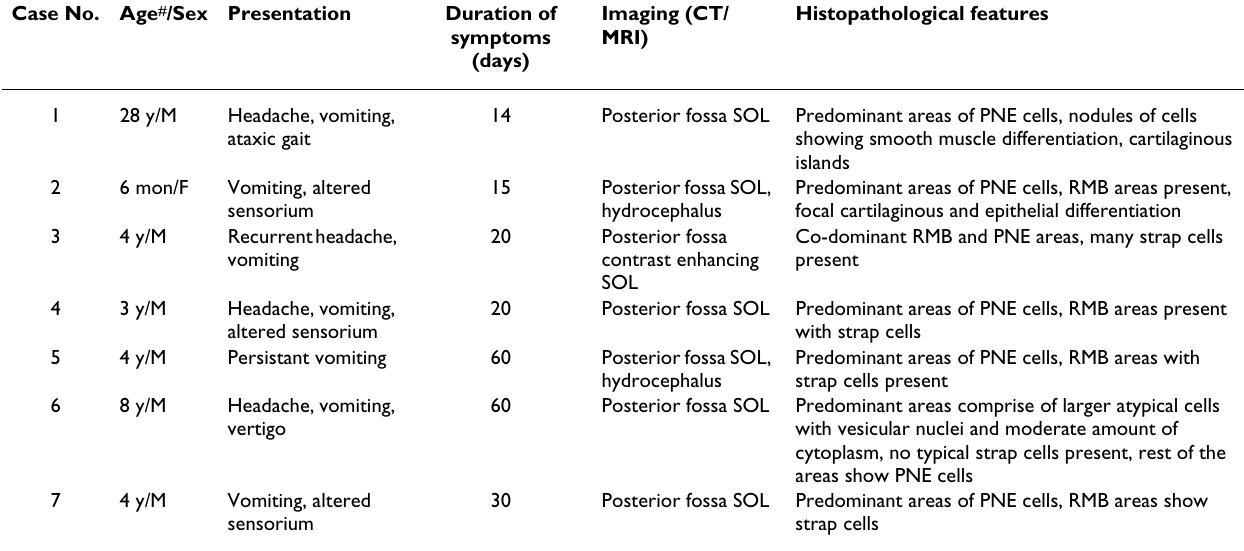
Table 1: Clinical data and histology of Medullomyoblastoma Case No. Age # /Sex